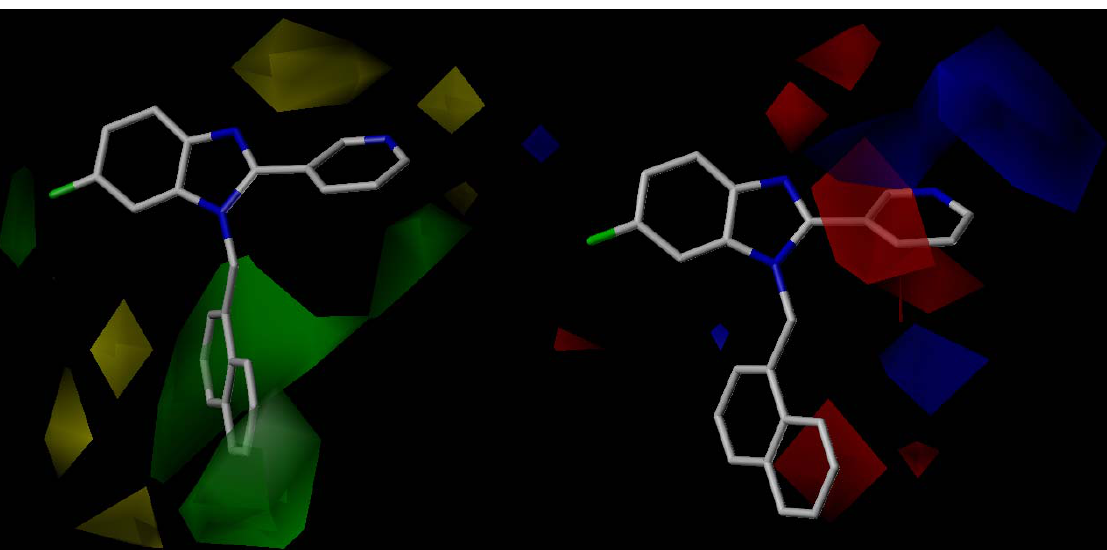
Figure 8. Left: CoMFA steric contour map for the most active compound 39 . The green contour indicates where a bulky group favors activity, while the yellow contour indicates where a small group favors activity. Right: CoMFA electrostatic contour map for the most active compound 39 . The blue contour indicates where positive charge favors activity, while a red contour indicates where negative charge favors